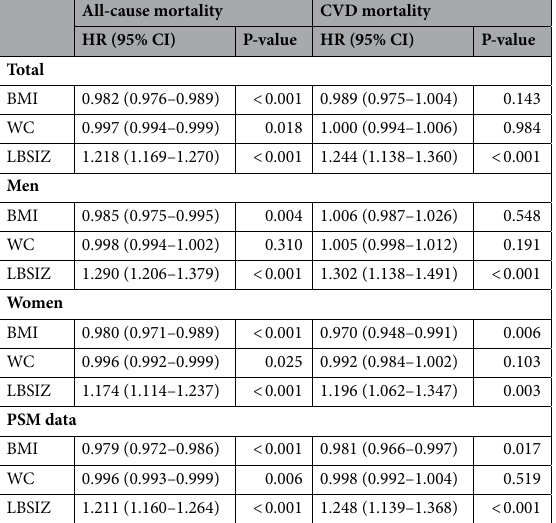
Table 3. Hazard ratio (95% confidence interval) for all-cause mortality and CVD mortality by each obesity parameter. Adjusted for age, sex, ethnicity/race, smoking status, alcohol consumption, history of cancer at baseline, diabetes mellitus, hypertension, dyslipidemia, and previous CVD event. BMI body mass index, WC waist circumference, LBSIZ z-score of the log-transformed A Body Shape Index, CVD cardiovascular disease.